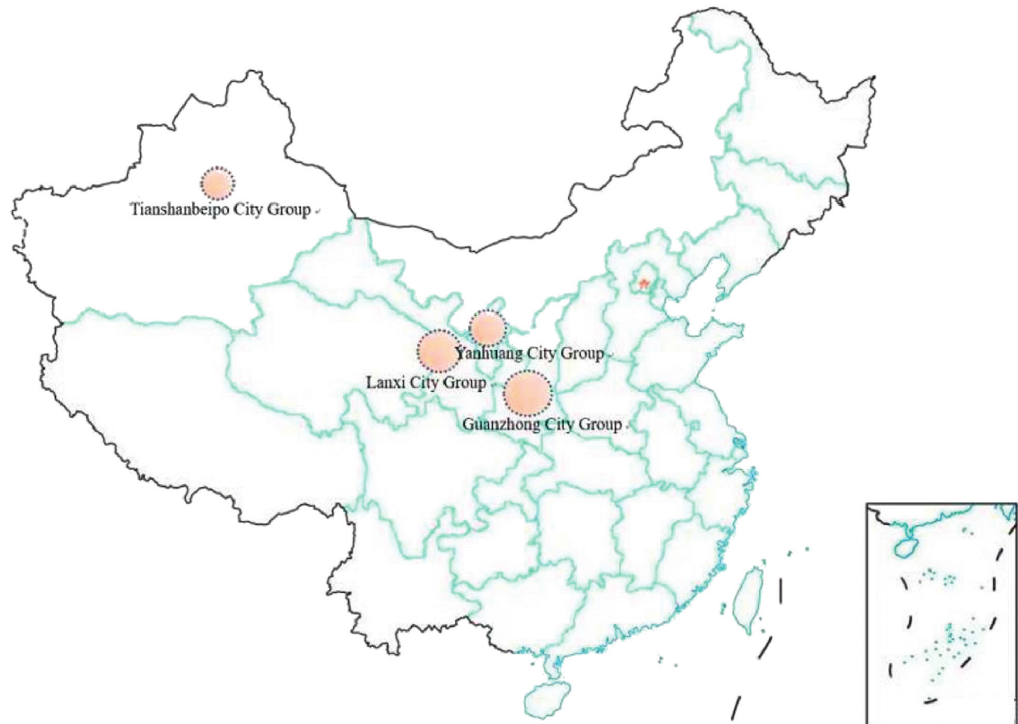
Figure 7: Location of urban agglomerations in Northwest China.